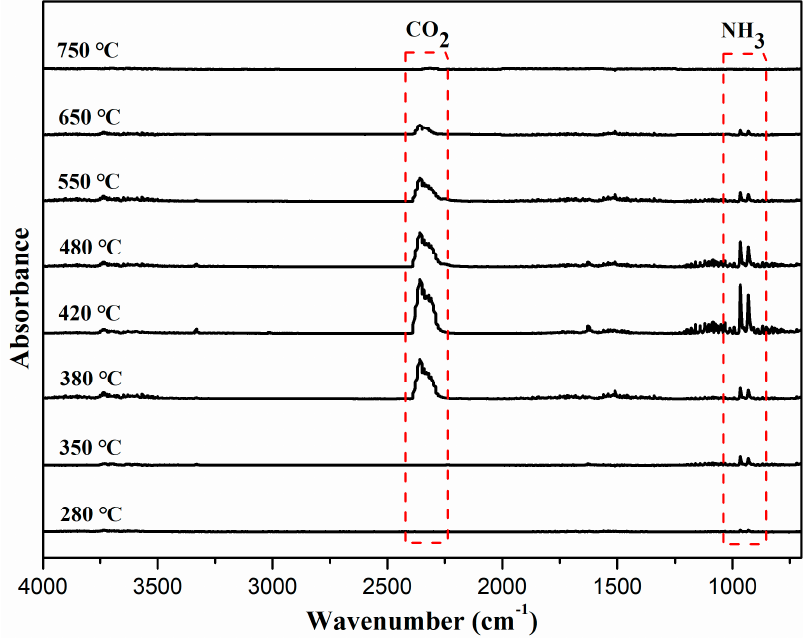
Figure 9. ( a ) TGA and ( b ) DTG curves of HDPE and HDPE/IFR composites in air atmosphere.